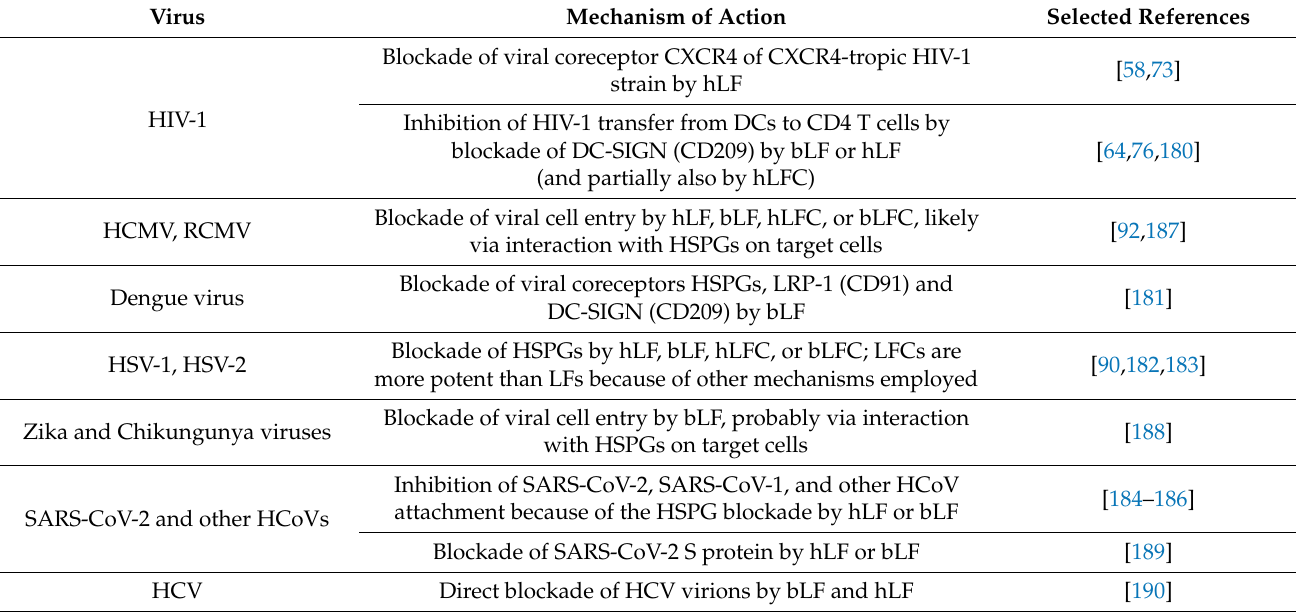
Table 2. Role of LF and LFC in inhibition of virus infection by targeting the virus or viral (co)receptors.